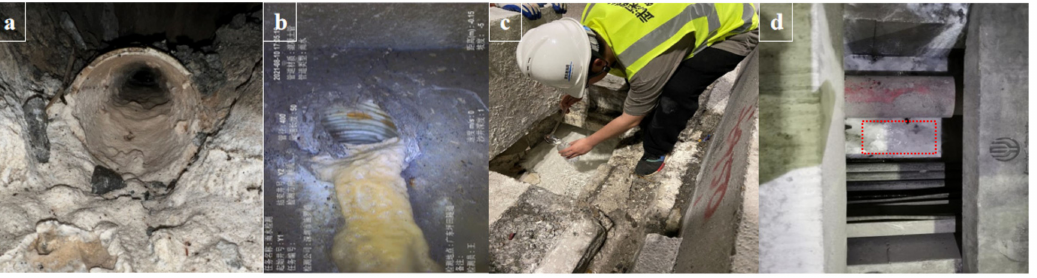
Figure 8. Crystal disease of tunnel drainage structure (( a ): longitudinal drainage pipe; ( b ): transverse drainage pipe; ( c ): roadside underdrain; ( d ): cable